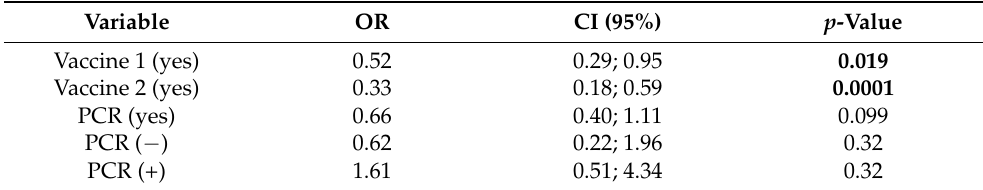
. V O 2 max * due to control of COVID-19.